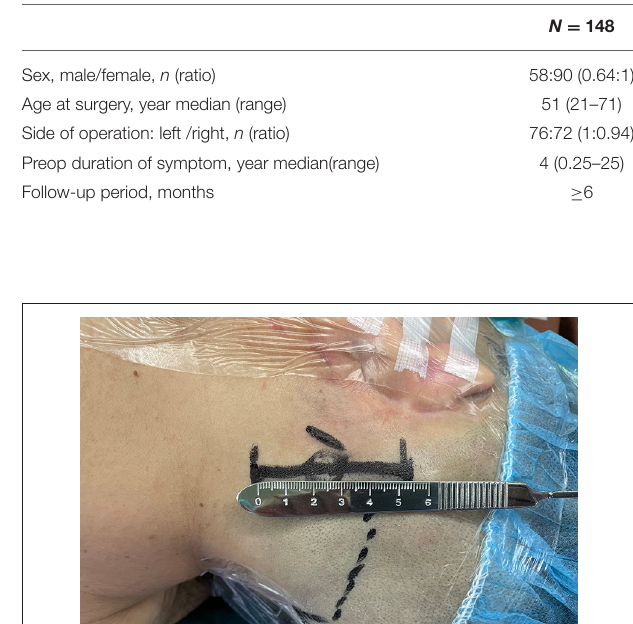
TABLE 1 | General characteristics of the patient population.